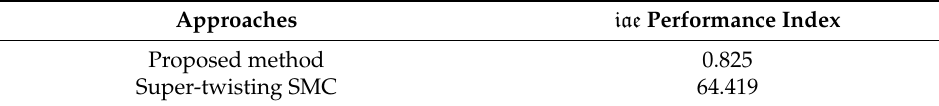
Table 1. Quantitative performance assessment.